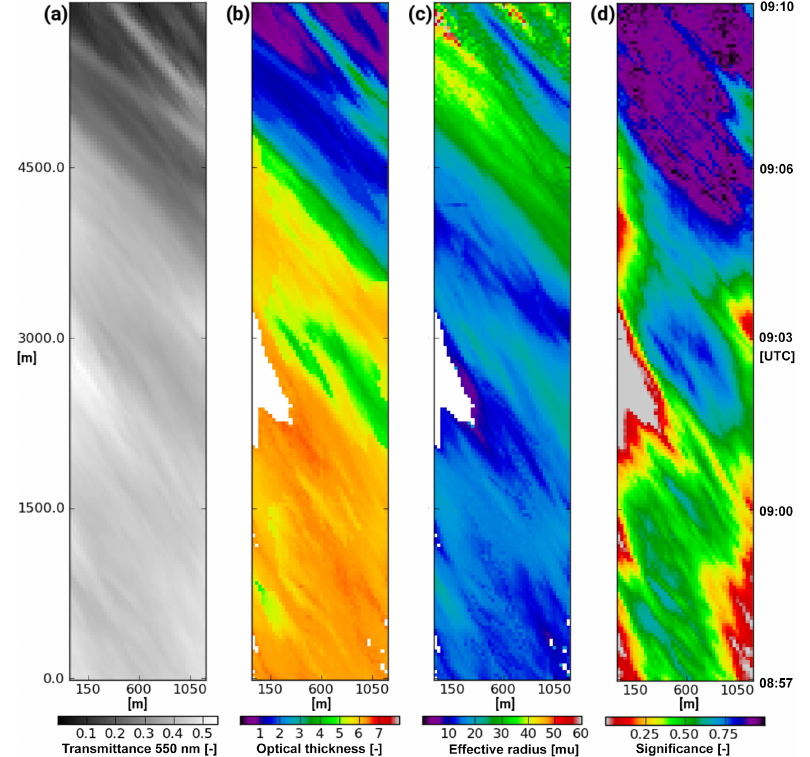
Figure 11. specMACS data at 550nm collected above UFS on 2 October 2012, 08:56–09:10UTC (a) , retrieval of effective radius (b) , optical thickness (c) and retrieval significance (d) ranging from 0 (no values in LUT within search radius) to 1 (a perfect match in the LUT). The spatial dimensions of the measurement resulting 1200 × 5970m are derived from cloud height (see Fig. 10) and advection wind speed.